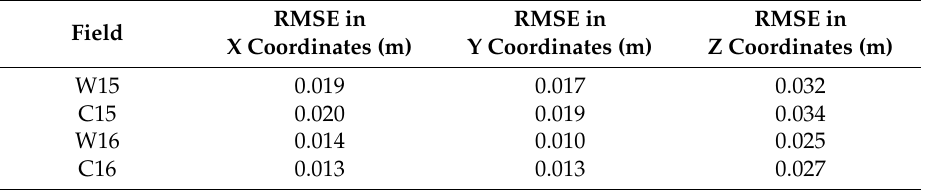
Table 3. Resulting root mean square error (RMSE) at ground control point (GCP) locations for GCP-based geo-referenced imagery for all fields (W15, W16, C15, and C16 in Figure 1).